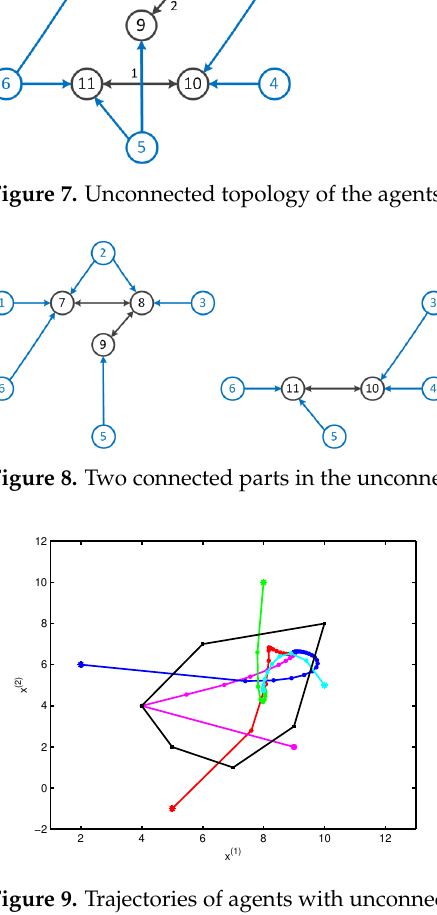
Figure 9. Trajectories of agents with unconnected topology.